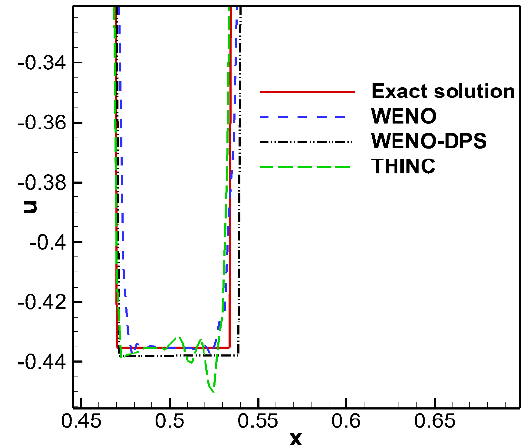
test case with 10 s  t